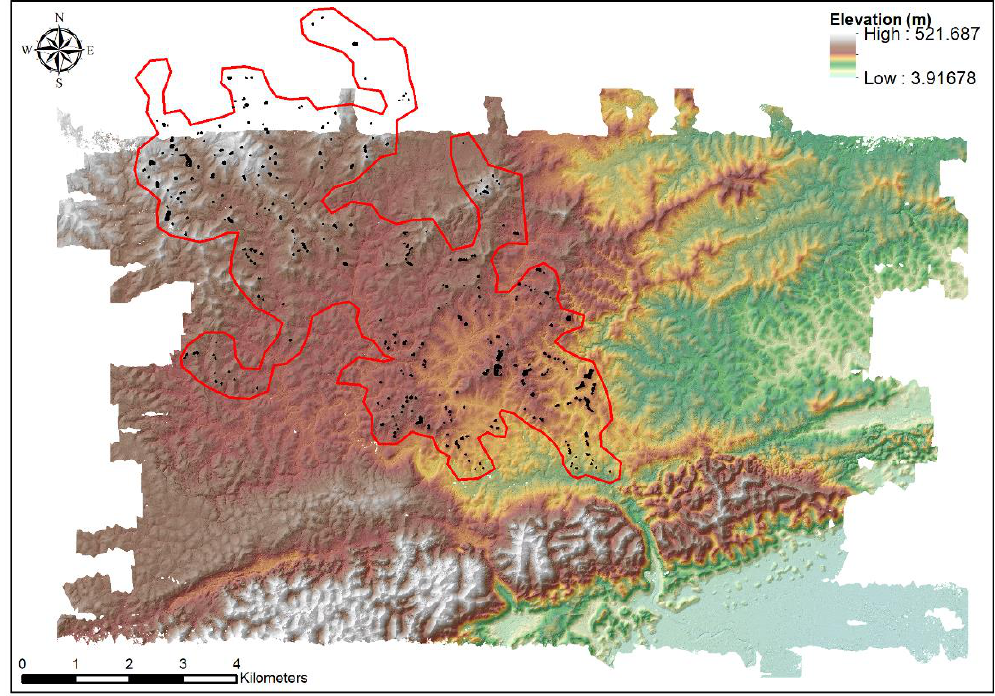
Figure 2. Settlement map of all documented Classic Maya structures at Uxbenká and Ix Kuku’il. Area of pedestrian survey is highlighted in red. (Note: Ix Kuku’il settlement system extends north beyond the lidar acquisition area. These plazuelas were not included in the comparative analysis).